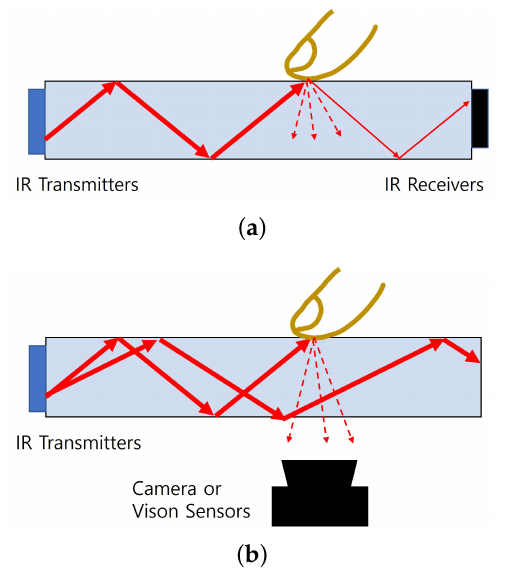
Figure 6. TIR-based IR touchscreen technologies. ( a ) PSD. ( b )